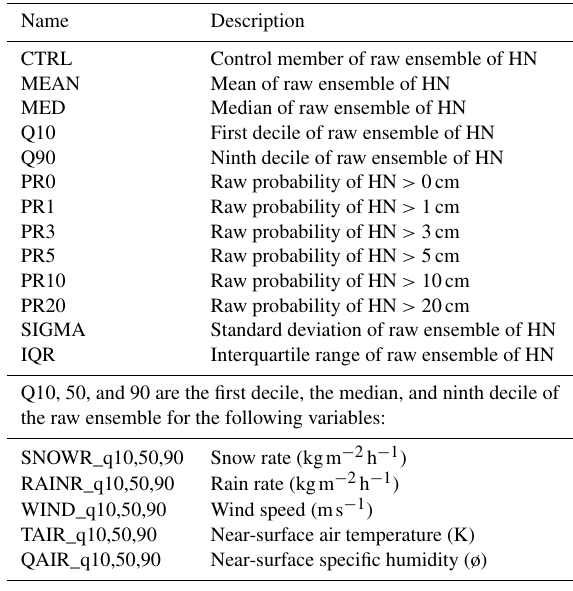
Table 1. Set of all available